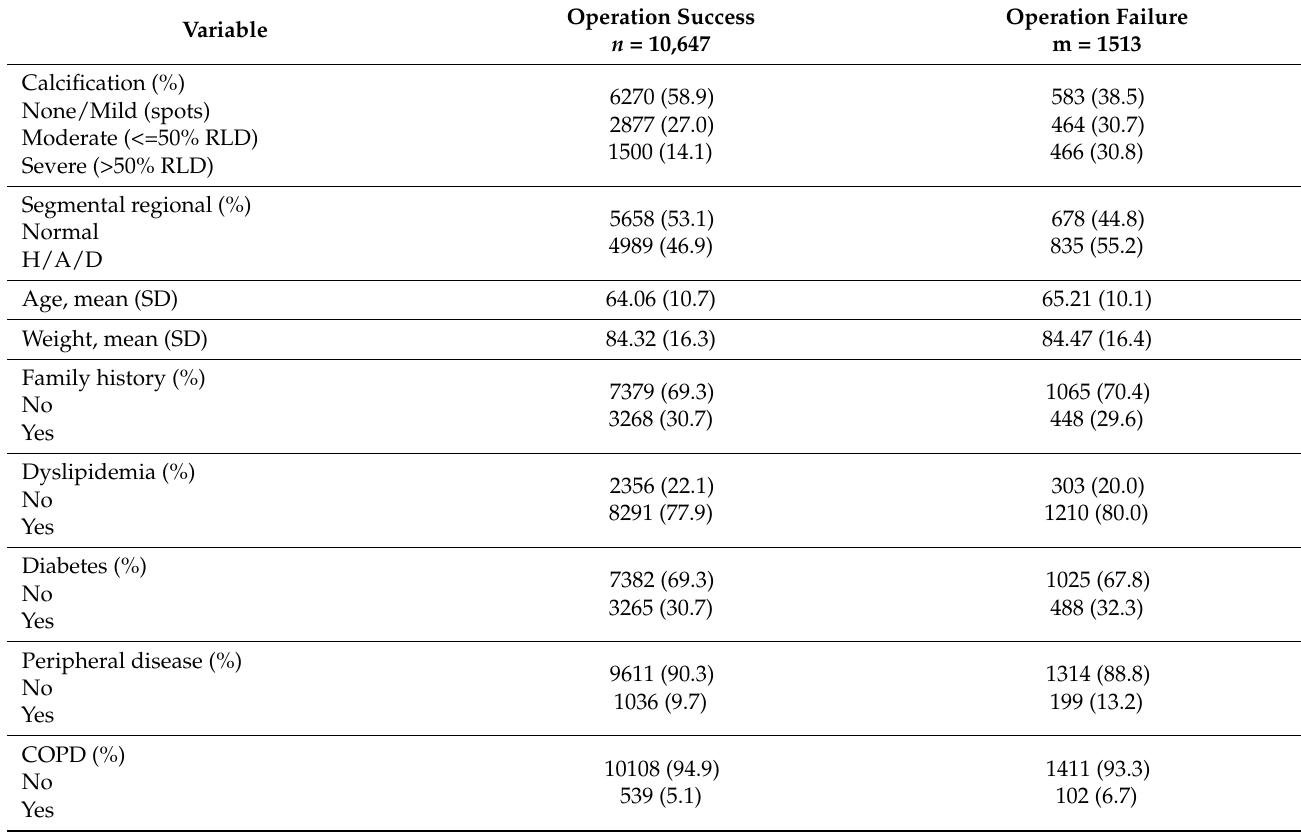
Table A2. Descriptive characteristics for the training dataset ( n = 12,160). For quantitative variables, the mean and standard deviation (in brackets) are displayed. For qualitative variables, the frequencies and corresponding percentages (in brackets) are displayed for each